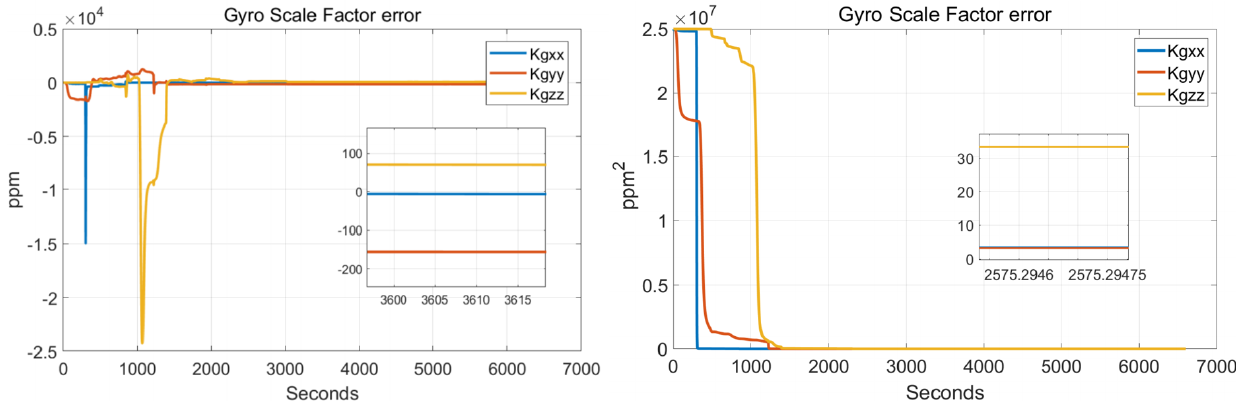
Figure 7. Gyro-scale factor